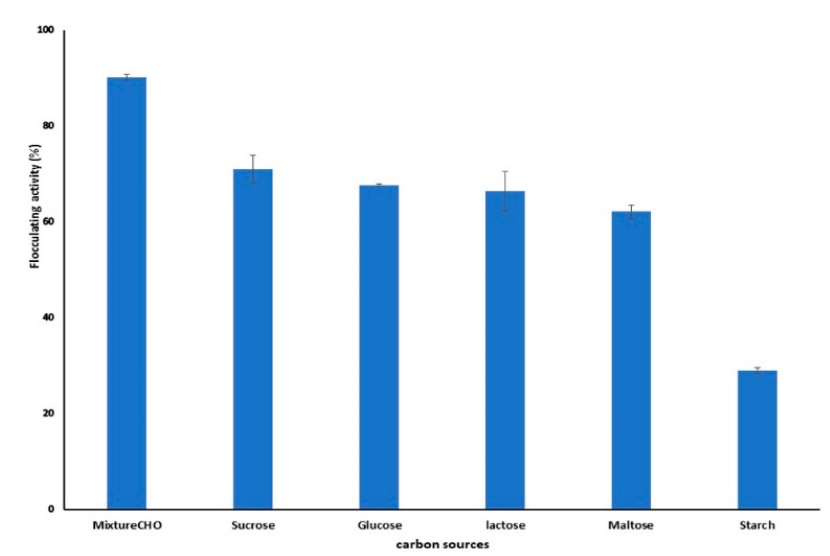
Figure 5. Effect of carbon source on bioflocculant production.